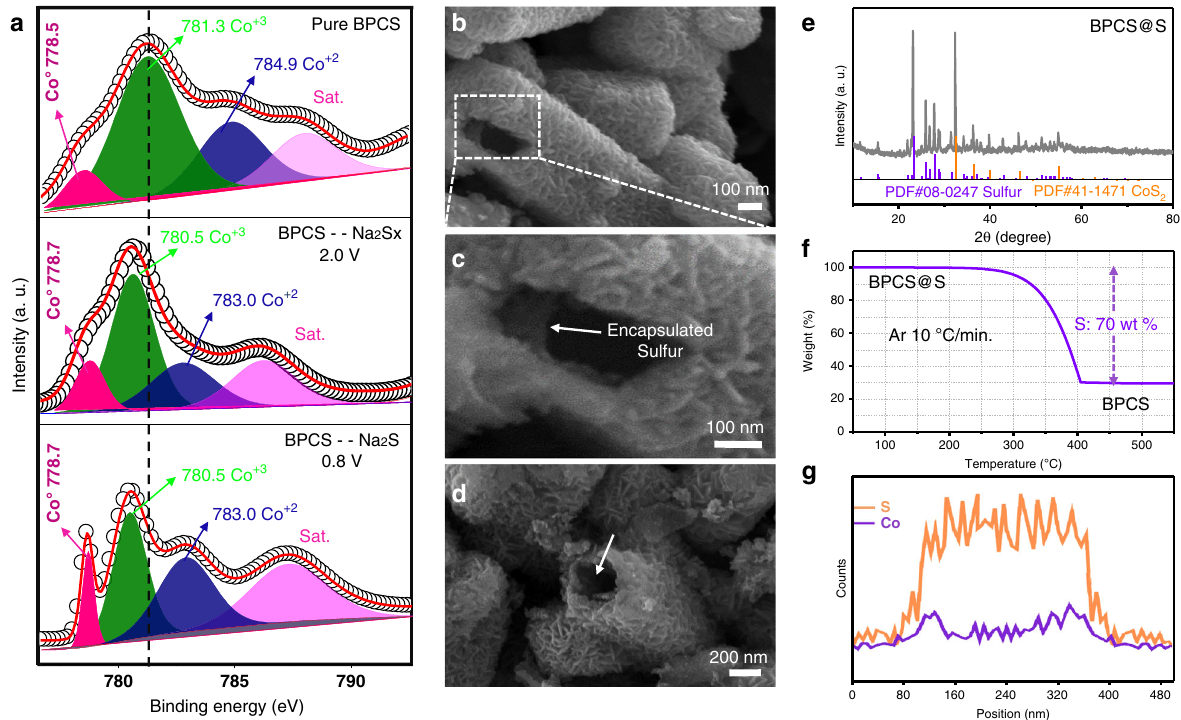
Fig. 3 Characterization of bipyramid prism like S@BPCS composite. a Comparison of the high resolution XPS of Co 2p3/2 of pure S@BPCS, after discharge at 2 V and 0.8 V. b – d FESEM images of S@BPCS composite. e XRD pattern. f TGA curve and g EDS line scan of 119.9 m 2 g − 1 and the hysteresis loop is of type H4 indicates the